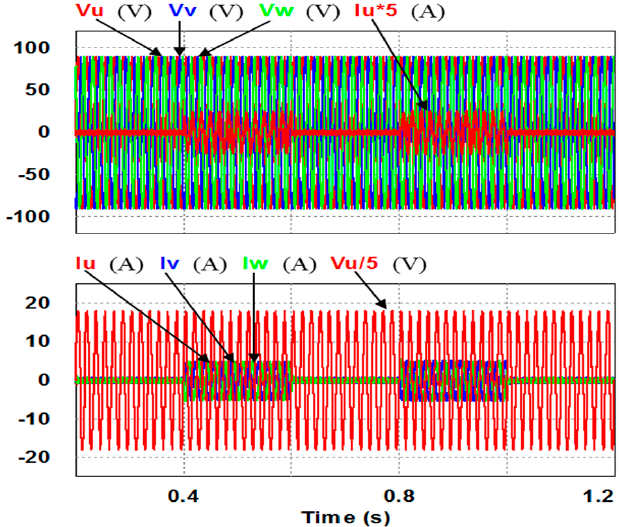
Figure 18. Case 2 simulation result: three-phase voltages and currents.